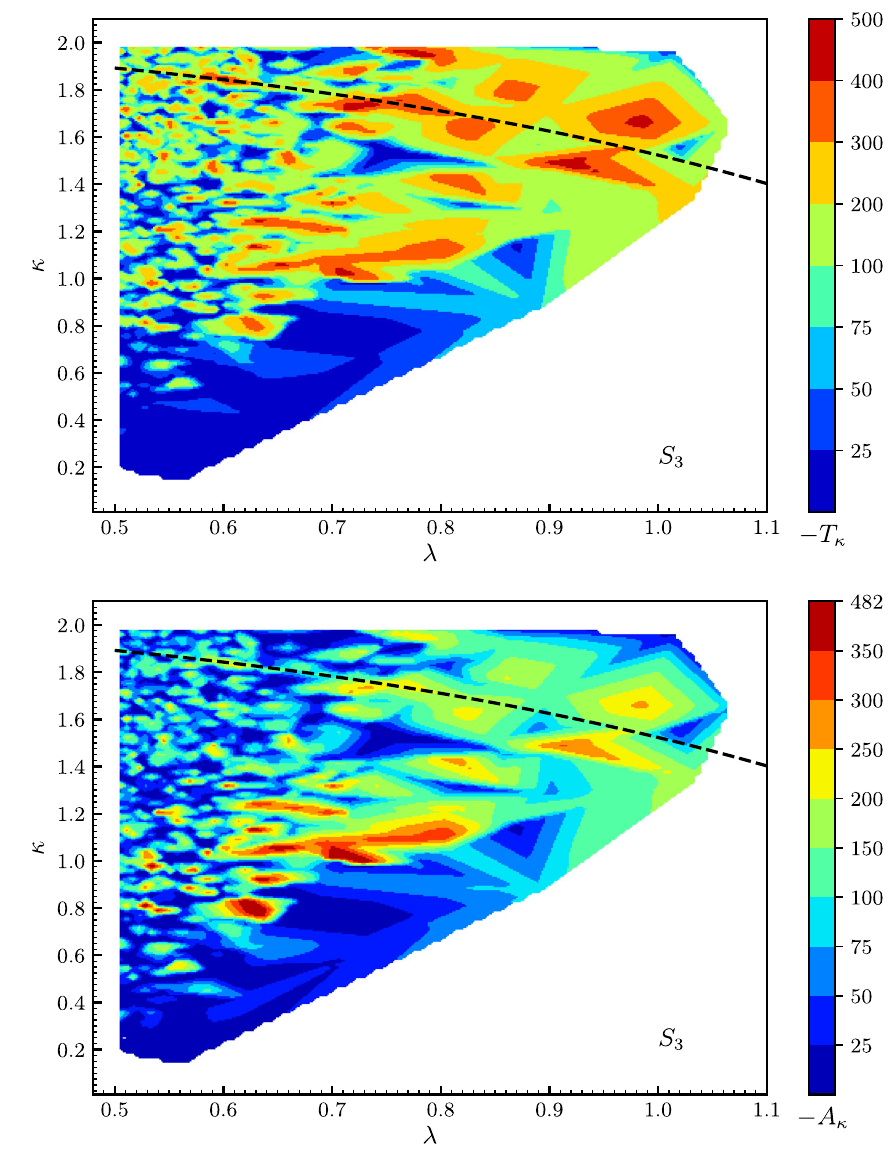
Fig. 38 The same as in Fig. 32, but the colours indicate different low-energy values of the trilinear soft terms T κ